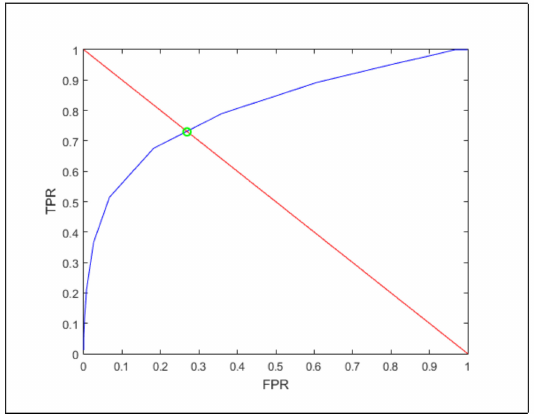
Figure 24. Equal Error